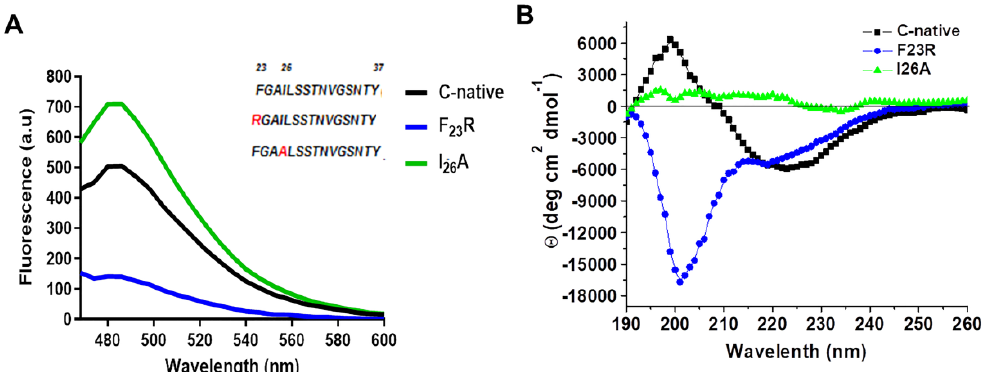
Figure 2. Structural characterization of C-terminal IAPP-derived peptides shows the inhibition of β -structures by the new F 23 R variant. ( A ) Fluorescence emission spectra through ThT assays on IAPP variants (60 µ g / mL). The characteristic emission peak was registered at 482 nm. ( B ) Circular dichroism (CD) spectra of hIAPP variants (190–260 nm). In this representative experiment, the peptide concentration was 120 µ g / mL.